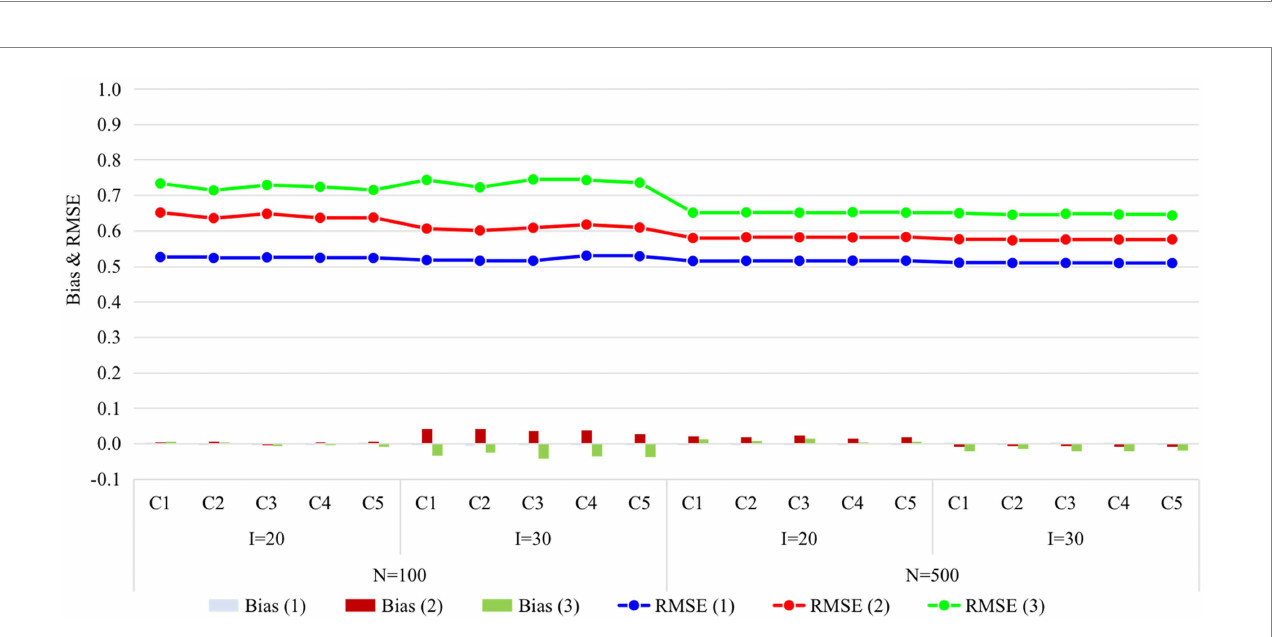
FIGURE 3 Recovery of ability in Study 1. I, number of items; N, sample size; Occasion is in parentheses; C1, four items outside R were set as anchor items; C2, four items inside R were set as anchor items; C3, eight items outside R were set as anchor items; C4, four items inside and four items outside R were set as anchor items; C5, eight items inside two Rs were set as anchor items; R, unit Q-matrix; RMSE, root mean square